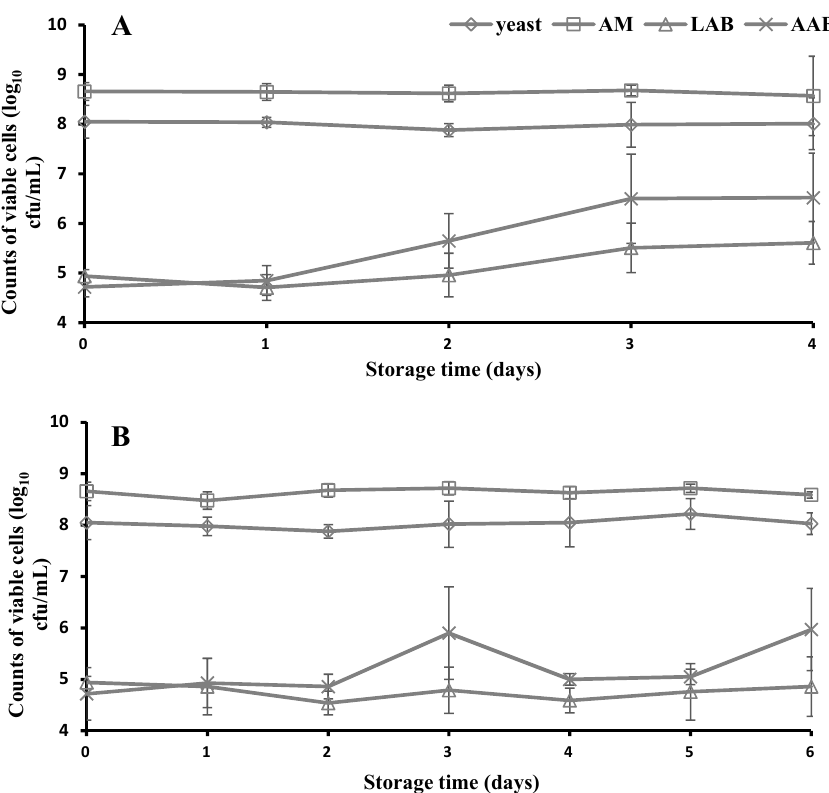
Figure 1. Evolution of aerobic mesophilic bacteria (AM), yeasts, lactic acid bacteria (LAB), and acetic acid bacteria (AAB) of tchapalo stored at ( A ) ambient temperature (28 to 30 °C) for four days and ( B ) 4 °C for six days.